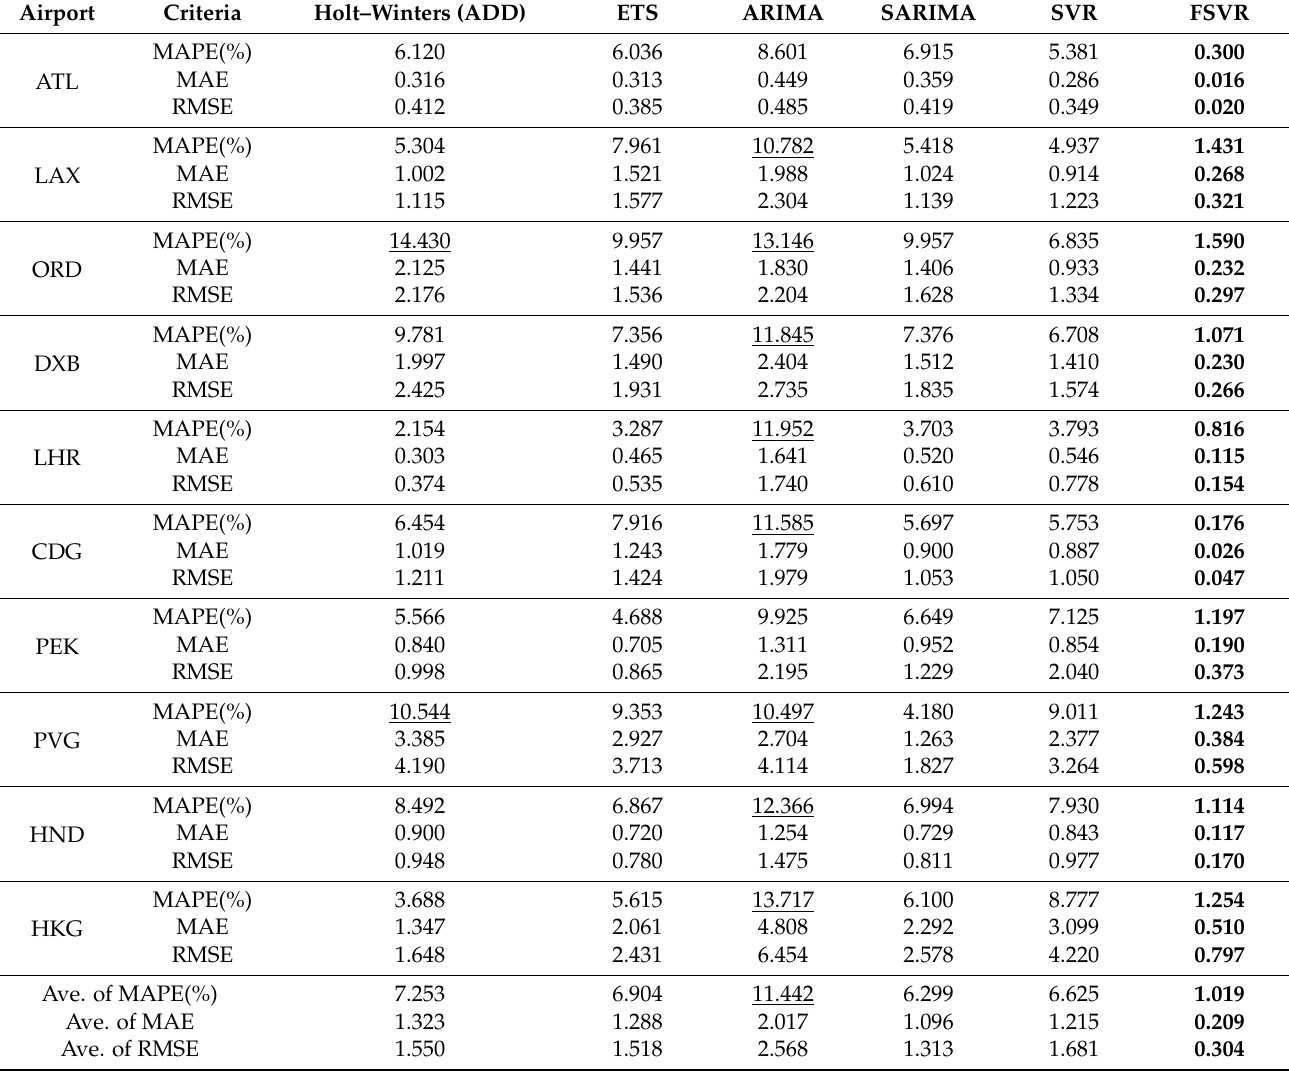
Table 4. The experimental results of the freight volume forecast model MAPE, MAE, and MAPE values.